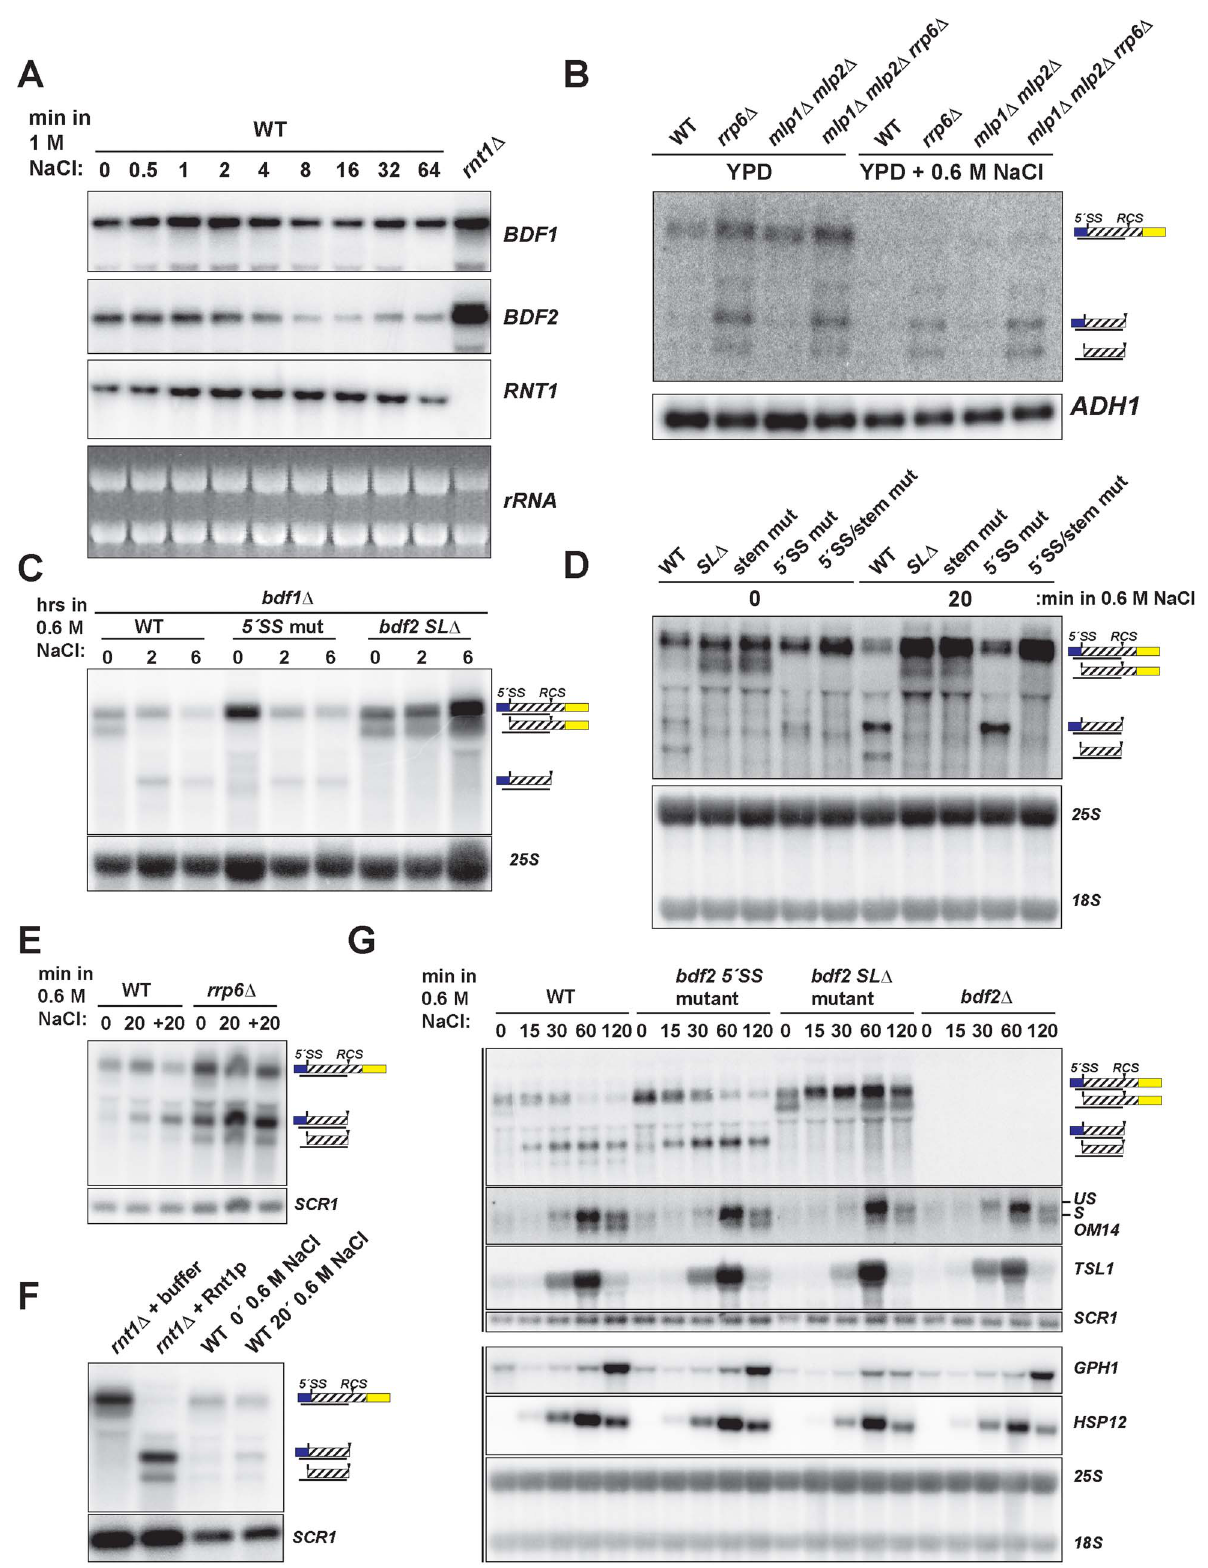
Figure 3. Hyper-activation of Rnt1p cleavage of BDF2 mRNA in osmotic stress. A . The wild-type strain was exposed to high salt stress (1 M NaCl) and harvested at the indicated time points by dispensing cultures directly into 2 80 u C pre-chilled ethanol. BDF1 and BDF2 were detected with riboprobes targeted to their respective 3 9 -UTRs. RNT1 was detected with a riboprobe targeted to its open reading frame. A strain deleted for RNT1 ( rnt1 D ) is included as a control (far right lane). The ethidium bromide-stained rRNAs are shown as loading controls. B . The indicated strains were